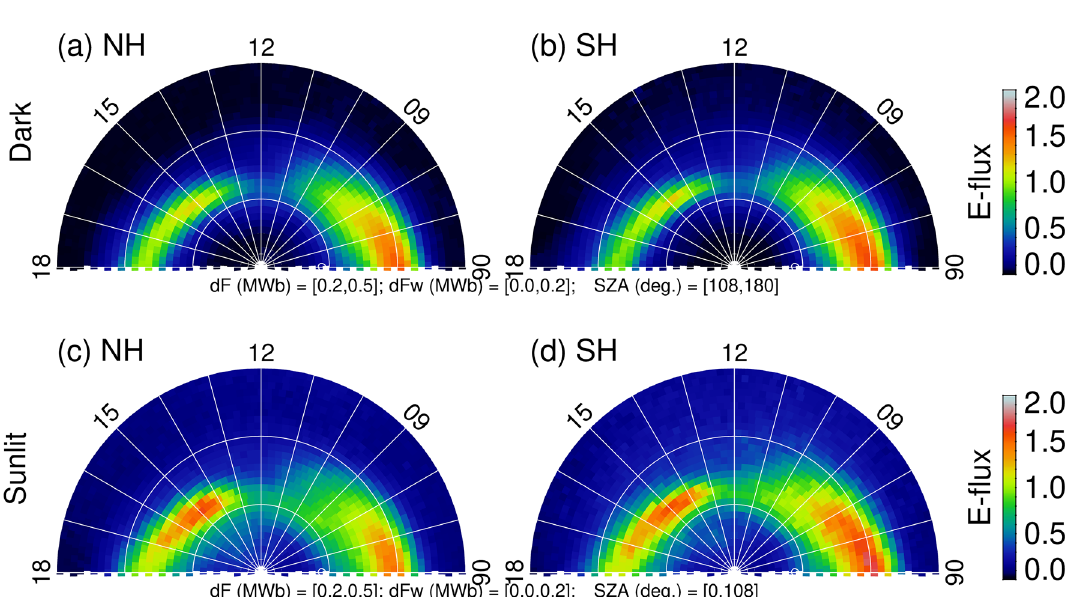
Figure 3. Averaged dayside auroral particle energy flux under ( a , b ) dark and ( c , d ) sunlit conditions for all IMF B y and weak solar wind driving ( d produced by the first author using the Interactive Data Language (IDL) software version 8.2.3. The ULR link for IDL is https ://www.harri sgeos patia